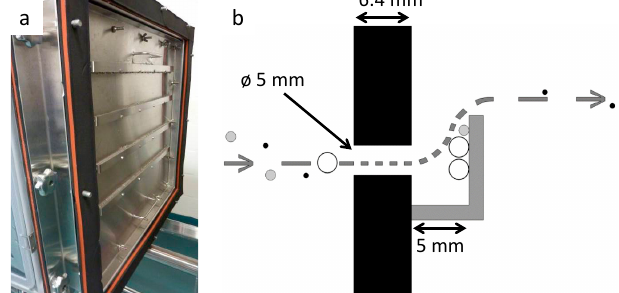
Figure 5. Particles separator. ( a ) Assembly of stainless steel plate with four rows of 40 orifices. On the picture, orifices are covered with impaction plates located 5 mm from the orifice’s outlets. ( b ) Schematic representation of the particle separator principle and design.